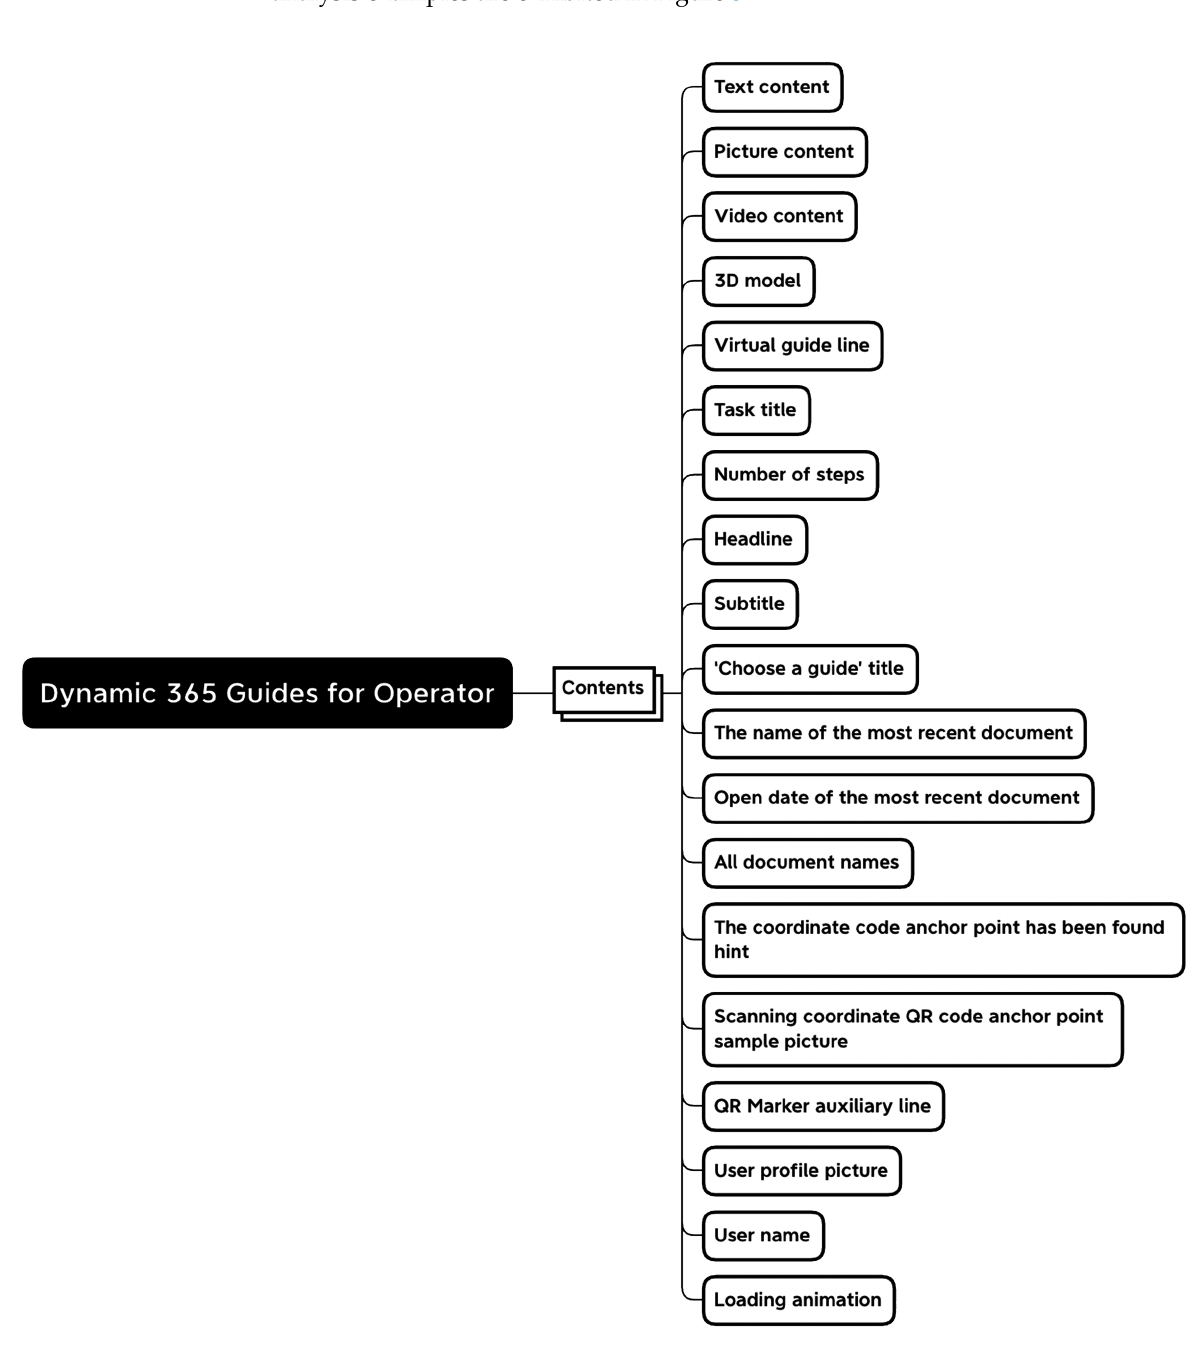
Figure 4. For an example of contents analysis of Dynamic 365